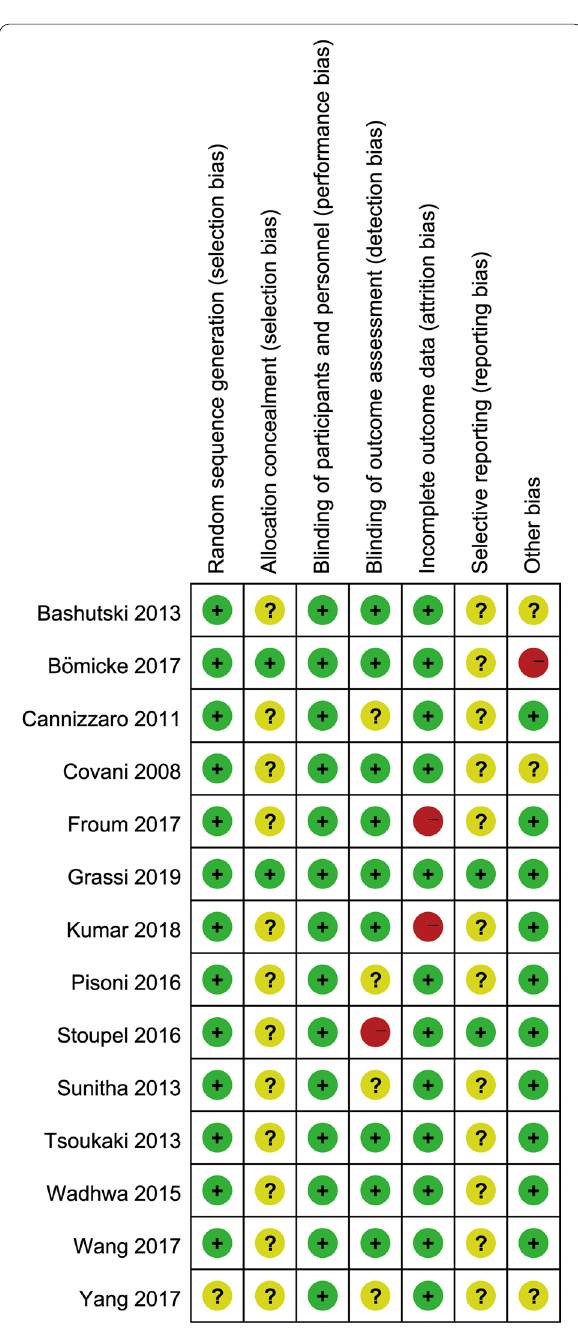
Fig. 3 Risk of bias summary: each risk of bias item for each included